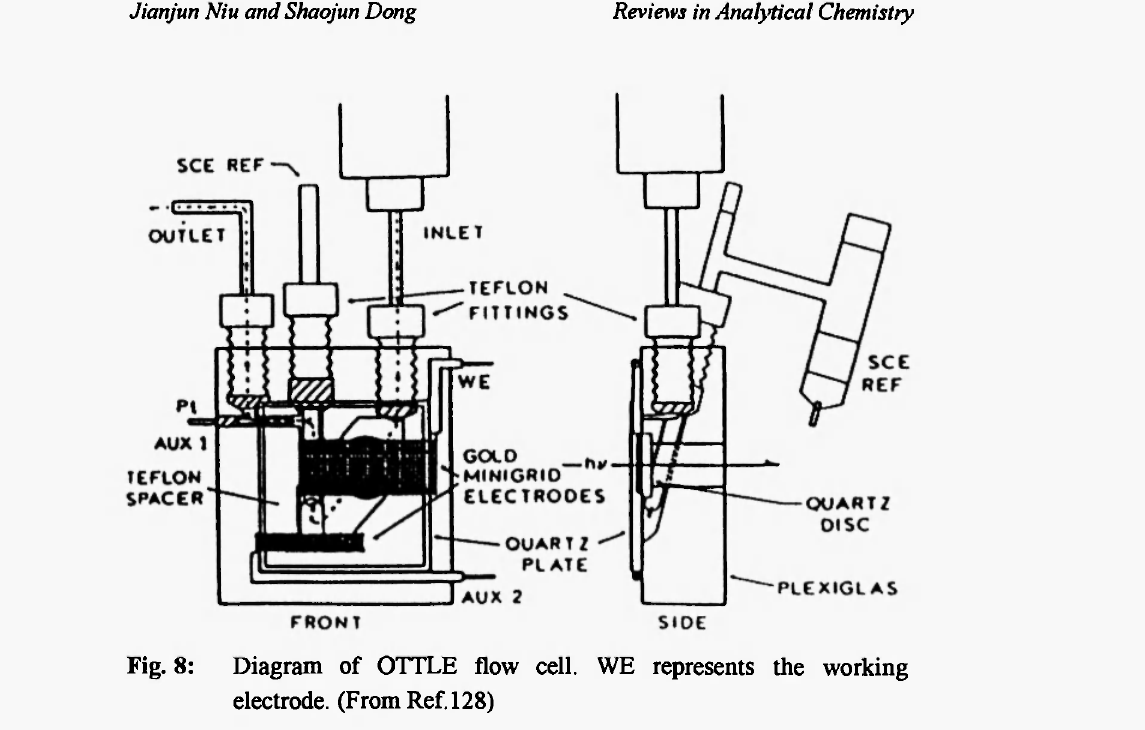
Fig. 8: Diagram of OTTLE flow cell. WE represents the working electrode. (From Ref.